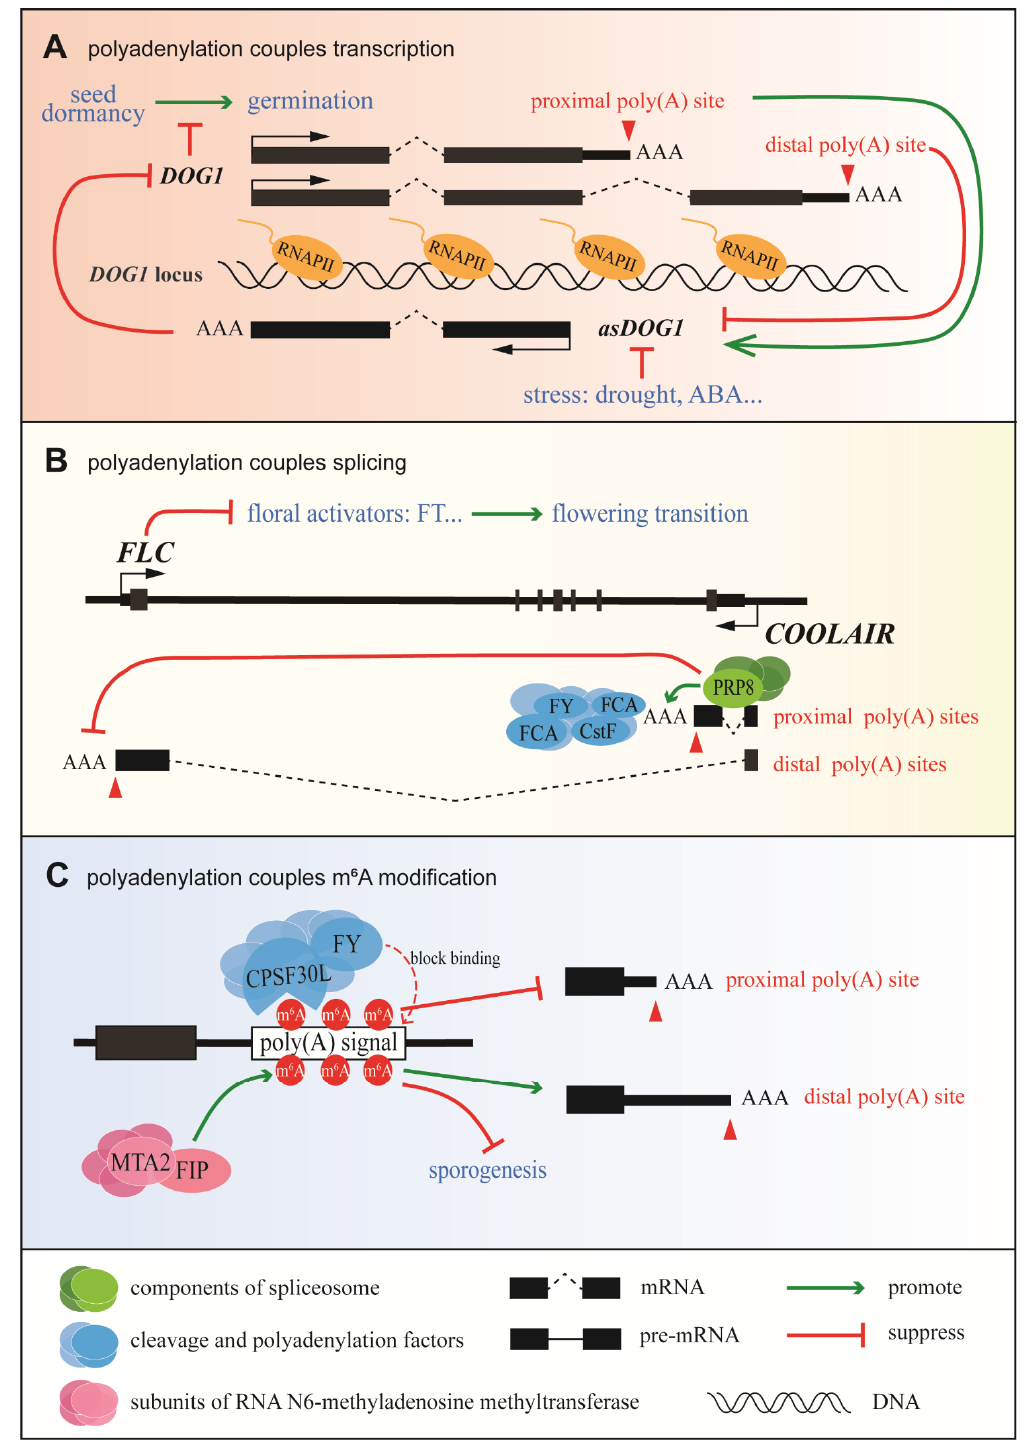
Figure 1. Schematic diagram of the coupling of transcription and RNA processing in plants. ( A ) Coupling between polyadenylation and the transcription of delay of germination 1 ( DOG1 ) in Arabidopsis . Increasing usage of the DOG1 proximal poly(A) site promotes the expression of asDOG1 , which subsequently suppresses DOG1 expression [55]. ( B ) Cou- pling between the polyadenylation and splicing of flowering locus C ( FLC ) transcripts in Arabidopsis . PRP8 facilitates the efficient splicing of the proximal intron in COOLAIR and promotes usage of the proximal poly(A) site in COOLAIR [31]. ( C ) Coupling between polyadenylation and m 6 A modification in plants. The m 6 A modification blocks binding of the polyadenylation factors CPSF30 and FY to the poly(A) signal, resulting in reduced usage of the proximal poly(A) site